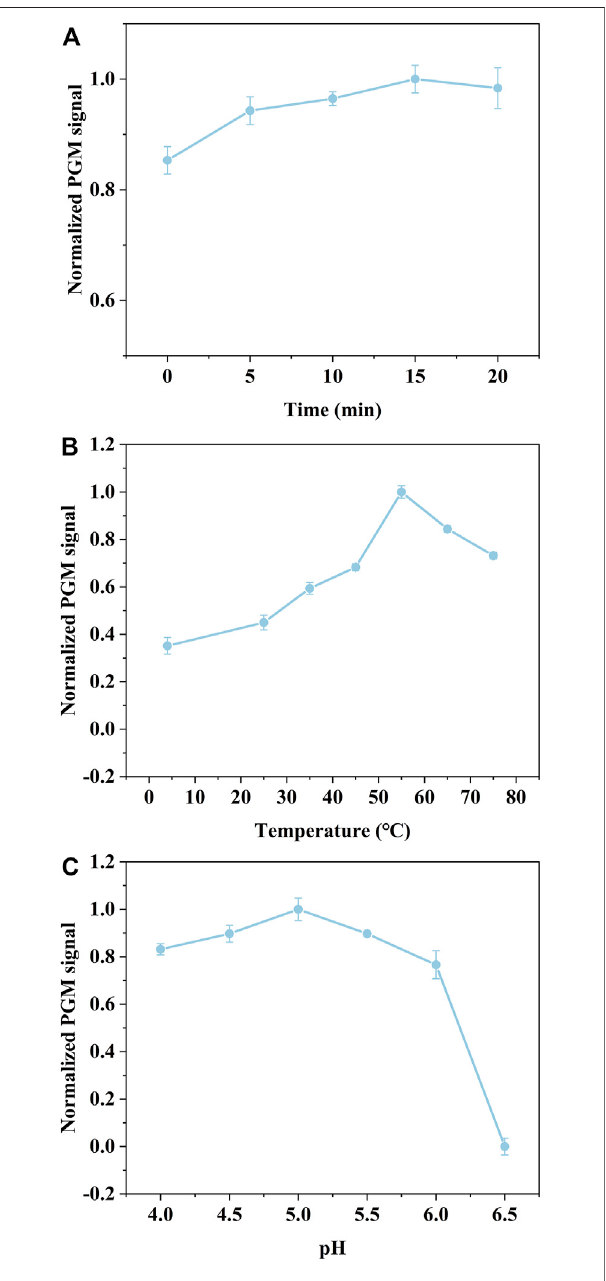
FIGURE5| EffectofthereactiontimeofbacteriacombinedwithAgNPs- invertase complexes (A) . Effect of temperature (B) and pH (C) for the catalytic activity of